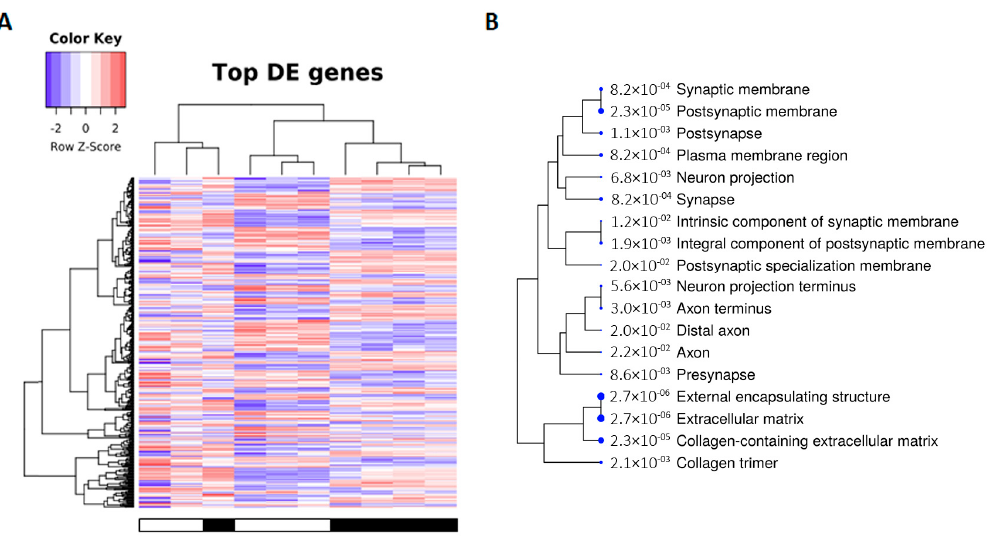
Figure 2. ( A ) Transcriptomic analysis shows differentially expressed (DE) genes in tau-KO mice compared with WT. After filtering, 69 were downregulated (purple tones), and 105 were upregu- lated (red tones). Deregulated transcripts are graphically illustrated in the heat map representation at a probability of an adjusted p -value < 0.05. Sample legend in the heat-map plot: white boxes cor- respond to wild-type animals, and black boxes correspond to tau-KO animals. ( B ) Enrichment anal- ysis against the Gene Ontology database ( p < 0.05) identifies primary altered genes corresponding to (i) synaptic structures, (ii) neuron cytoskeleton and transport, and (iii) extracellular matrix com- ponents. The blue dot size beneath each gene cellular component category is proportional to the enrichment FDR score number (between dot and category name) obtained from the differentially expressed genes involved in the functional group.